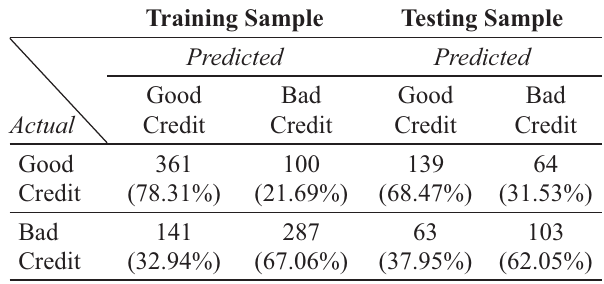
Table 4. Classifi cation results using CART for training and testing samples